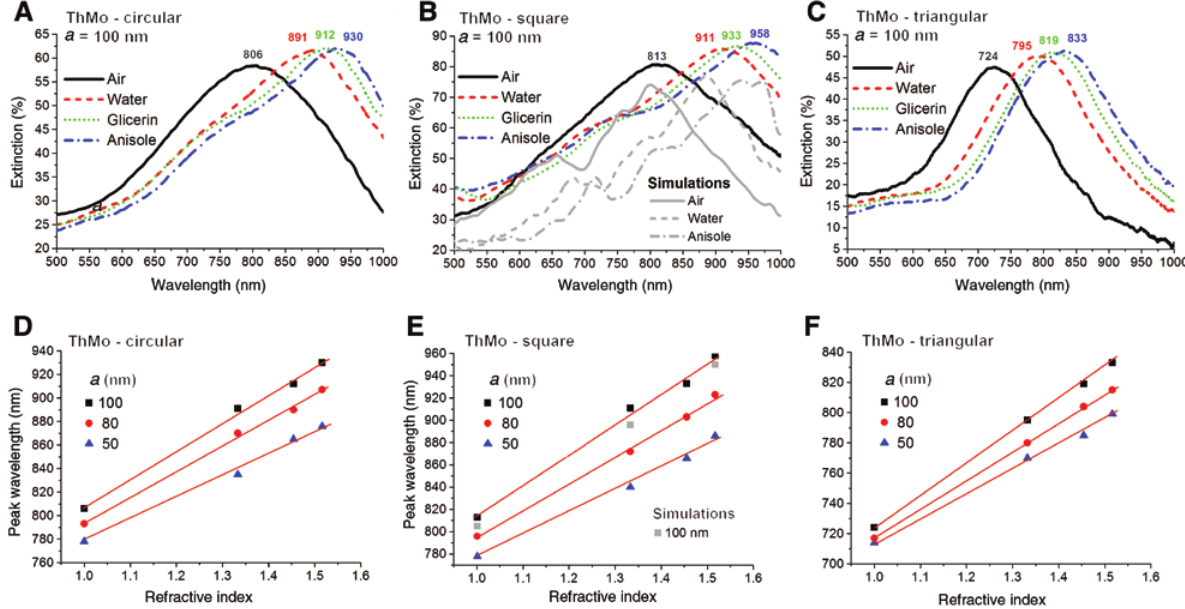
Figure 5: Size- and shape-dependent optical properties of Au NPs in ThMo arrangement. Extinction spectra of ThMo nanopatterns with d = 180 nm, a = 100 nm and circular (A), square (B), and triangular (C) NPs. Trends of the LSPR peak wavelength versus the refractive index of the medium achieved for ThMo investigated with different minimum interparticle distance a and circular (D), square (E), and triangular (F) NPs. In (B) and (E), the spectral response obtained by numerical simulations is reported in grey color.